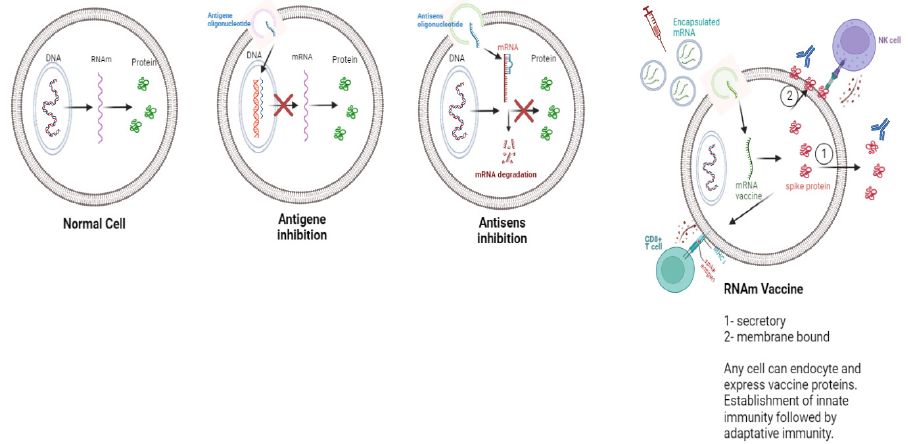
Figure 1. Different RNA or DNA based therapy strategies.